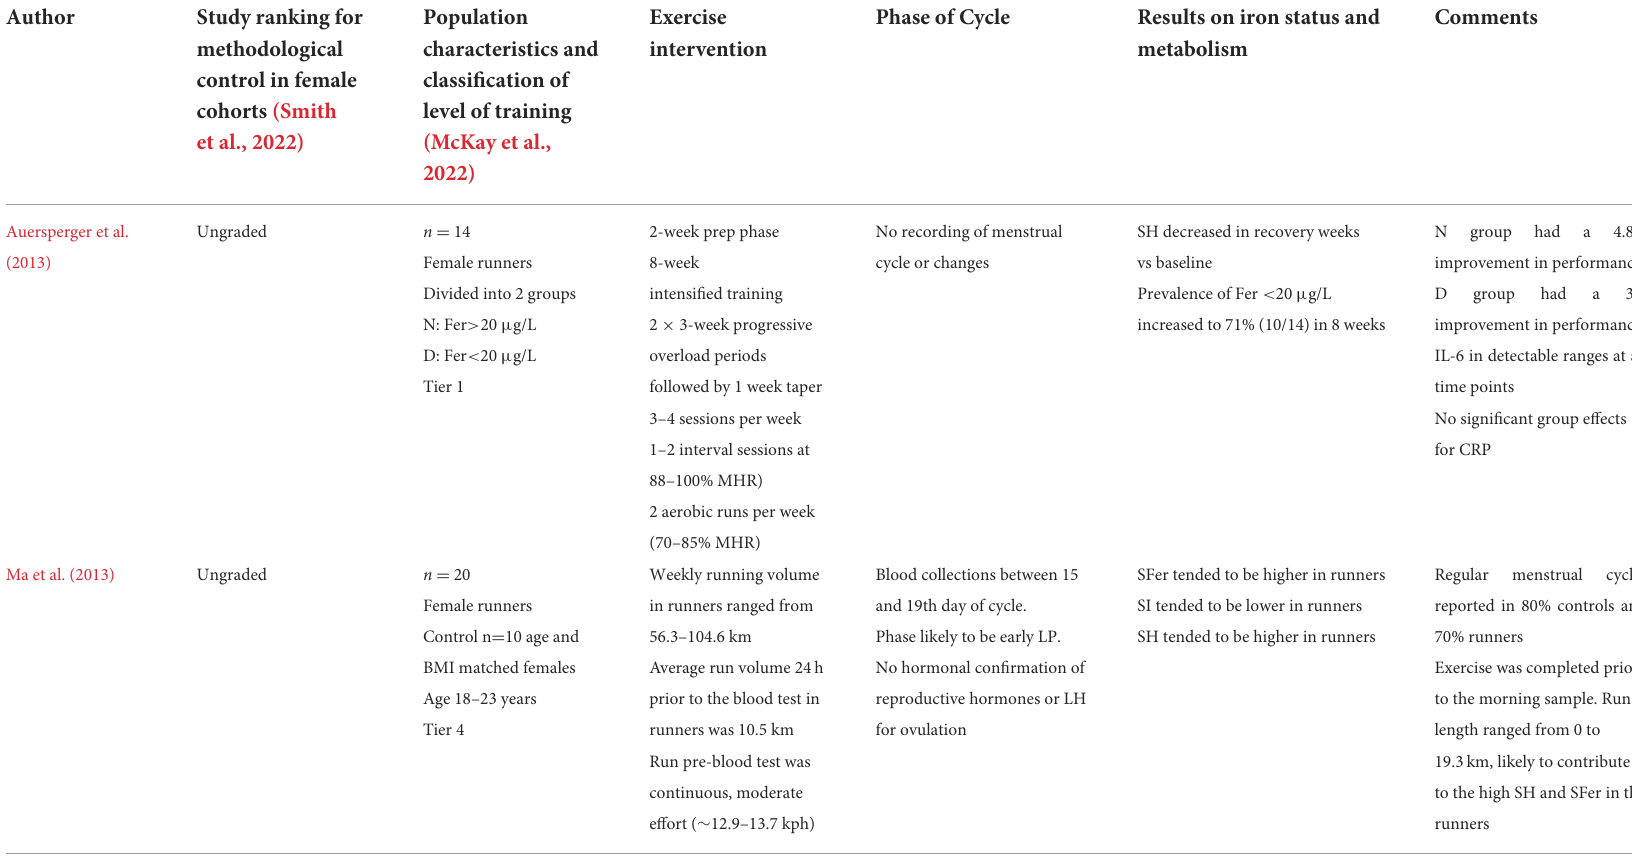
TABLE 3 Studies that have investigated changes in hepcidin and iron parameters pre and post chronic training periods in premenopausal